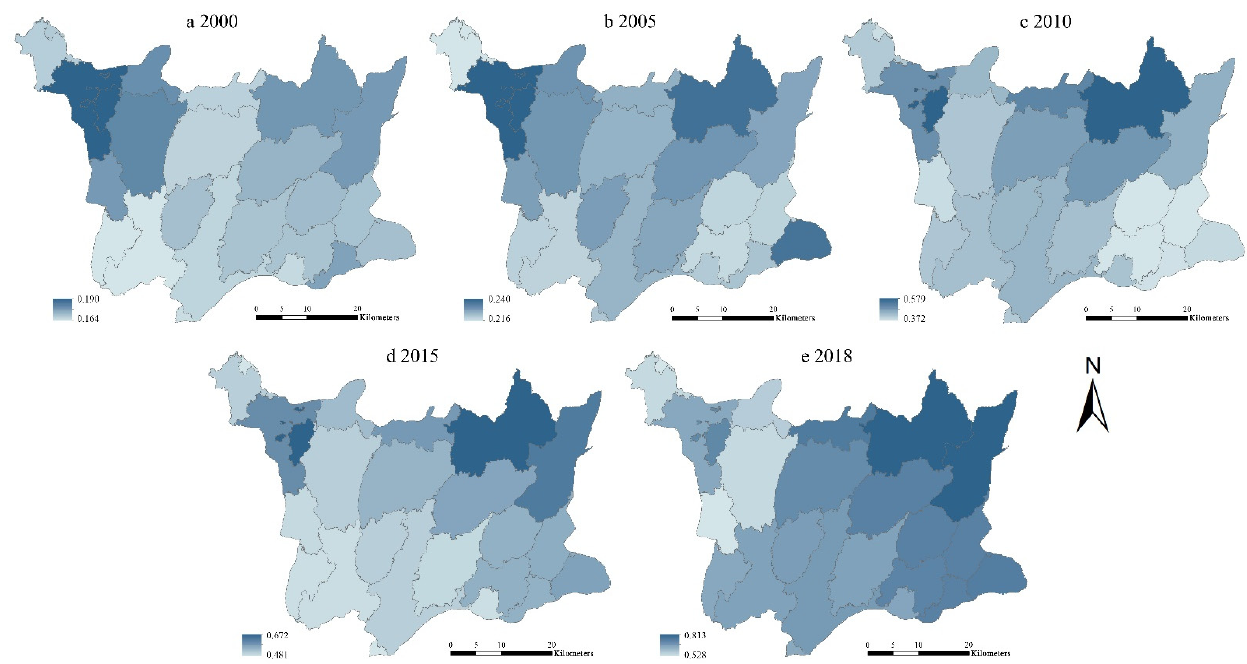
Figure 5. Distribution of TESI in Huanggang Dabieshan UGGp from 2000 to 2018.